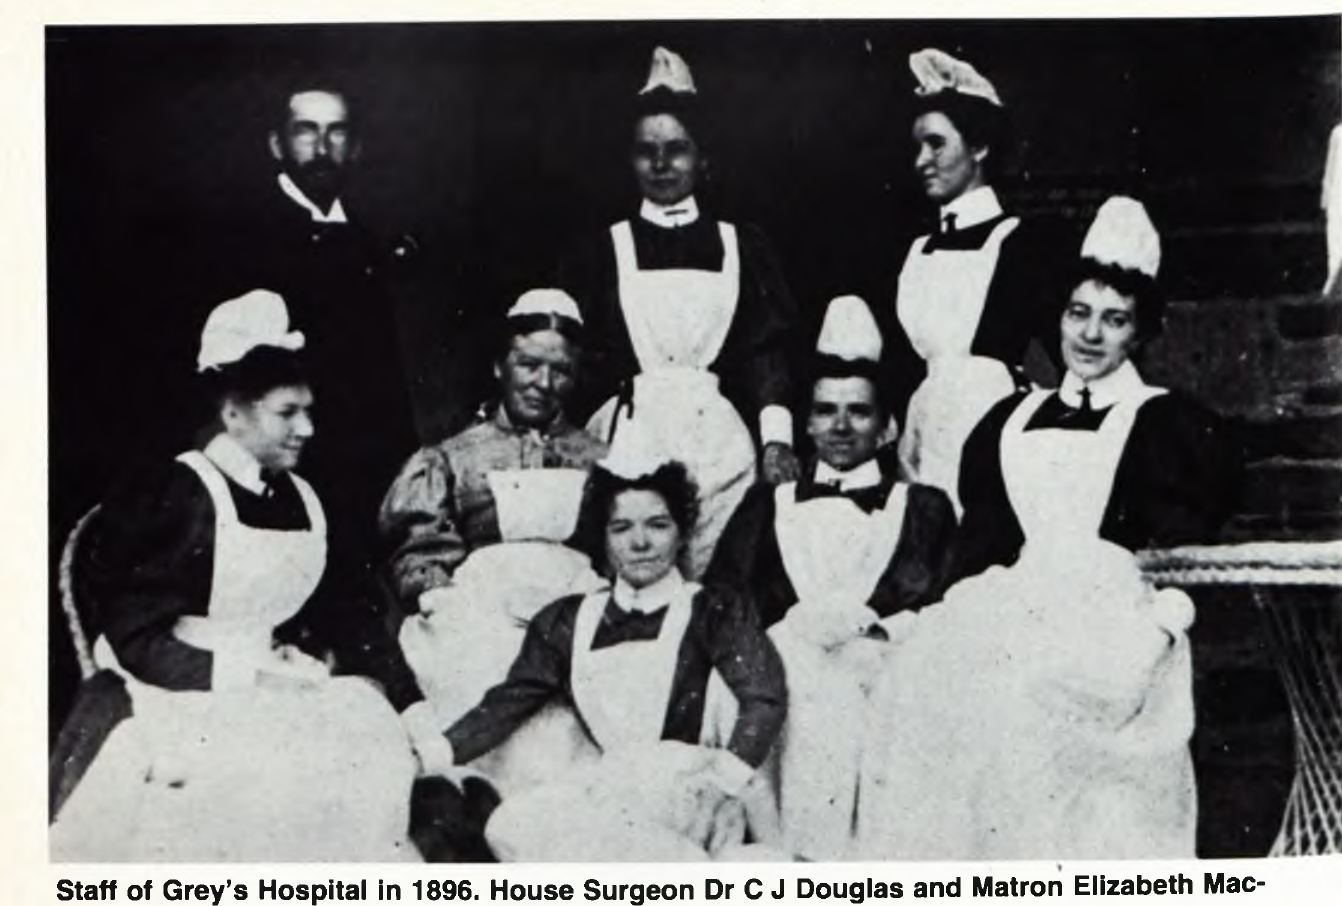
Staff of Grey’s Hospital in 1896. House Surgeon Dr C J Douglas and Matron Elizabeth Mac­ donald with probationer